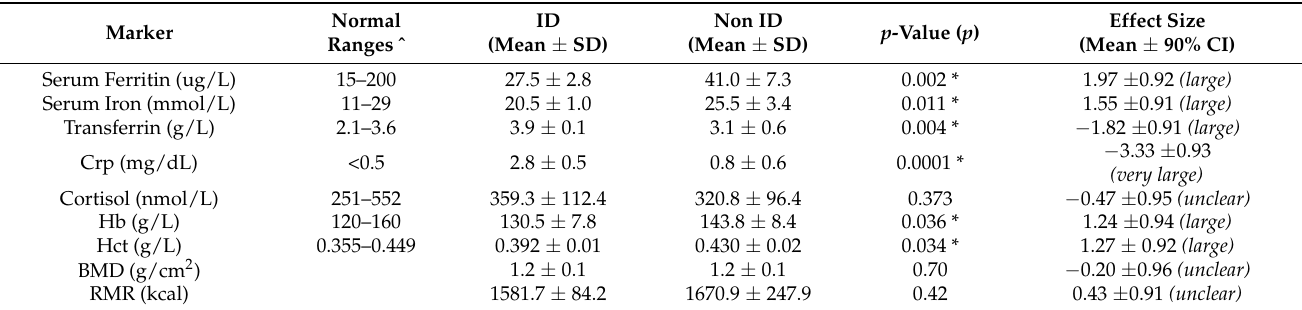
* Indicates statistical significance ( p < 0.05). ˆ Normal ranges, as provided by the clinical laboratory where testing took place. Correlations between variables are shown in Table 3. Crp was positively correlated with cortisol ( r = 0.31) and transferrin ( r = 0.70), as well as negatively correlated with serum ferritin ( r = − 0.66), iron ( r = − 0.72), and RMR ( r = − 0.52). Total training duration and